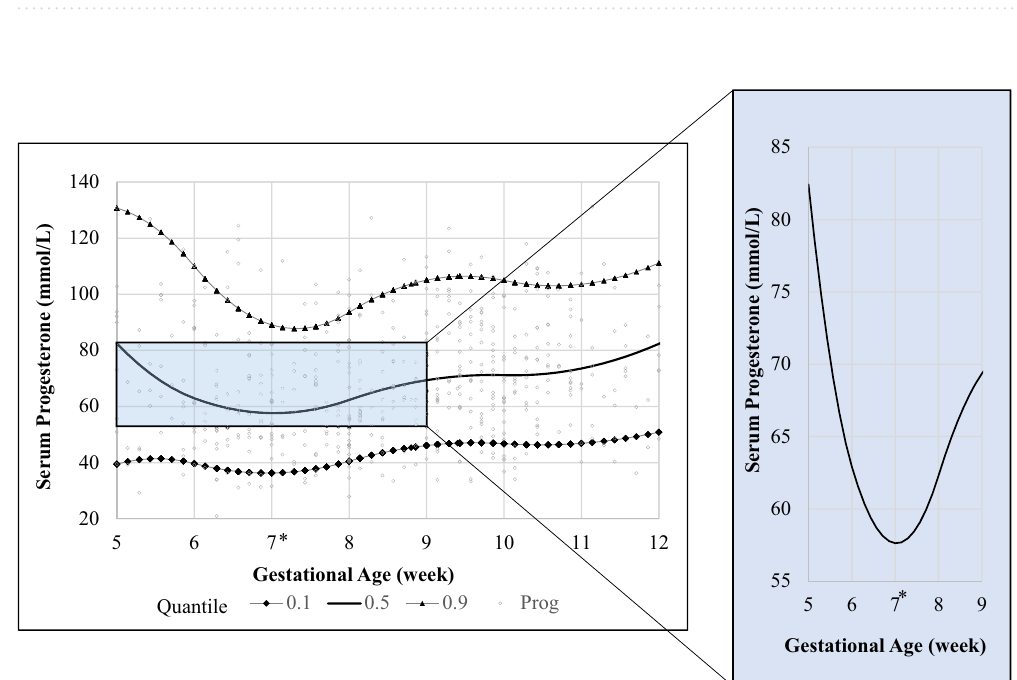
Figure 2. Gestational age-specific 10th, 50th and 90th percentile normative values of serum progesterone. Restricted cubic splines with knots at 6, 8 and 10 weeks were used to describe the shape of the serum progesterone trajectory across gestation. *Mean serum progesterone at gestational week 7 (63.4 nmol/L) compared against week 5 (75.0 nmol/L, p = 0.029), week 6 (66.9 nmol/L, p = 0.694), week 8 (67.7 nmol/L, p = 0.374) and week 9 (78.0 nmol/L, p <